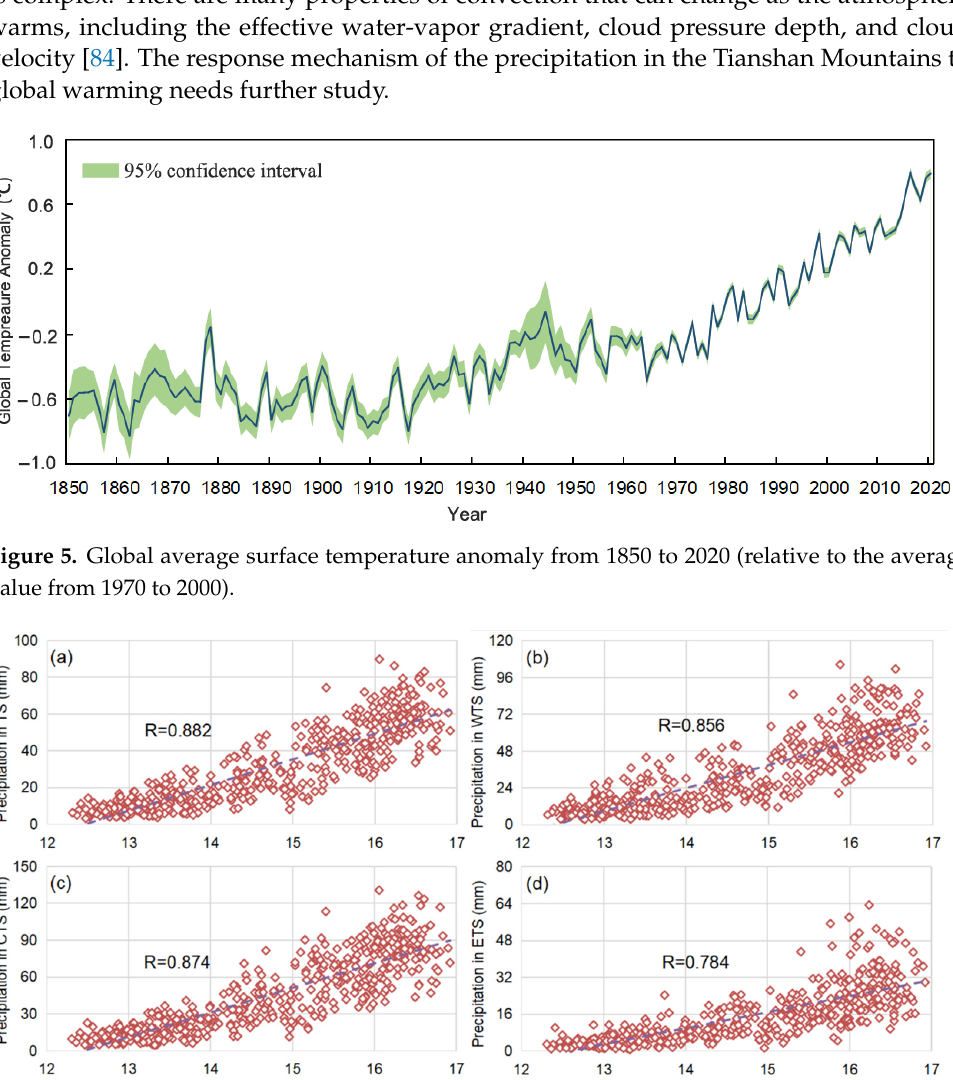
Figure 4. Spatial changes of the slope of annual precipitation in the Tianshan Mountains.